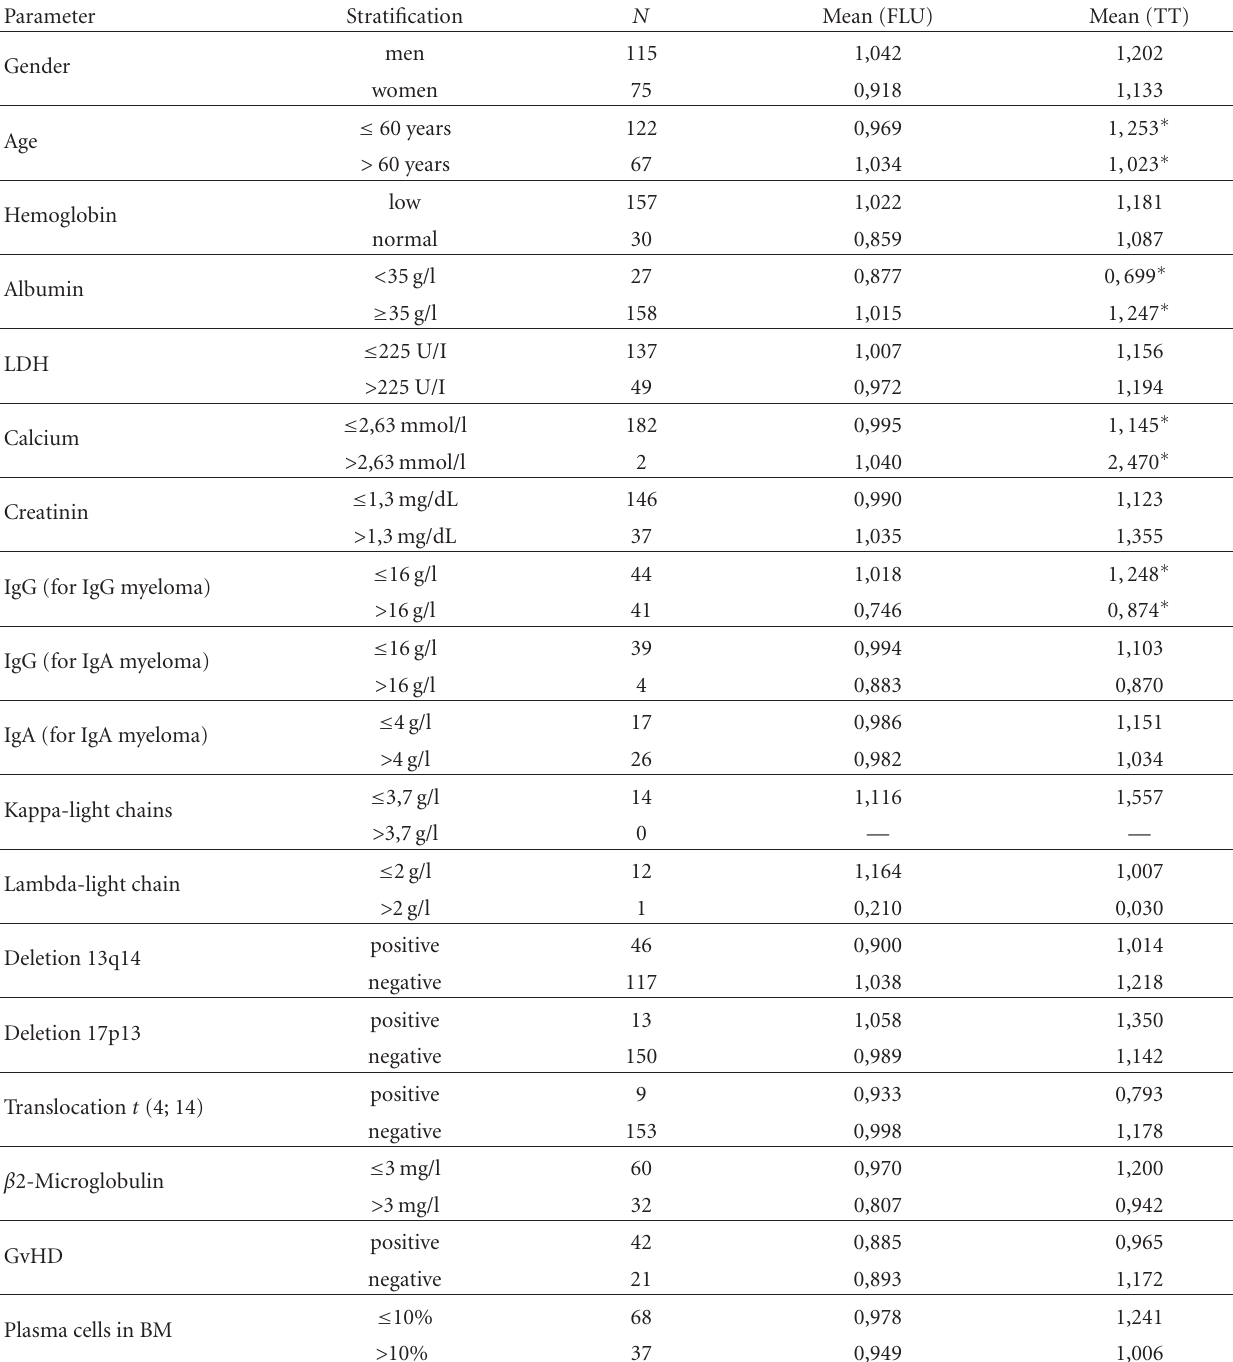
Table 2: correlation of FLU-antibodies and TT-antibodies with clinical